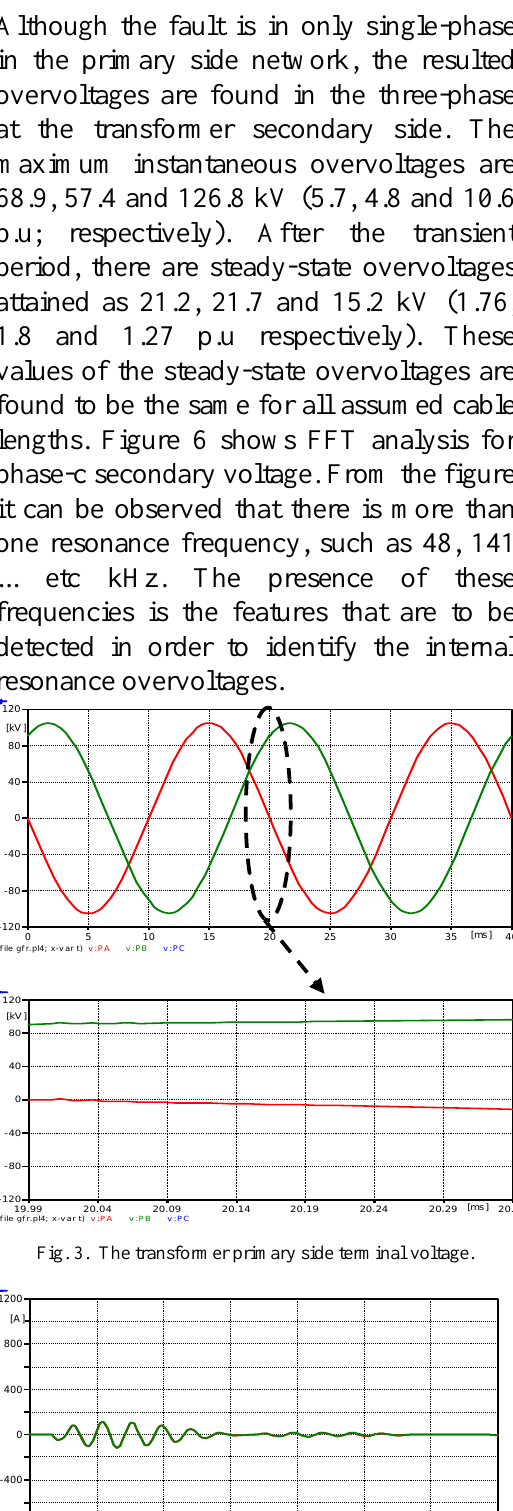
Fig.2.a. Studied power system.